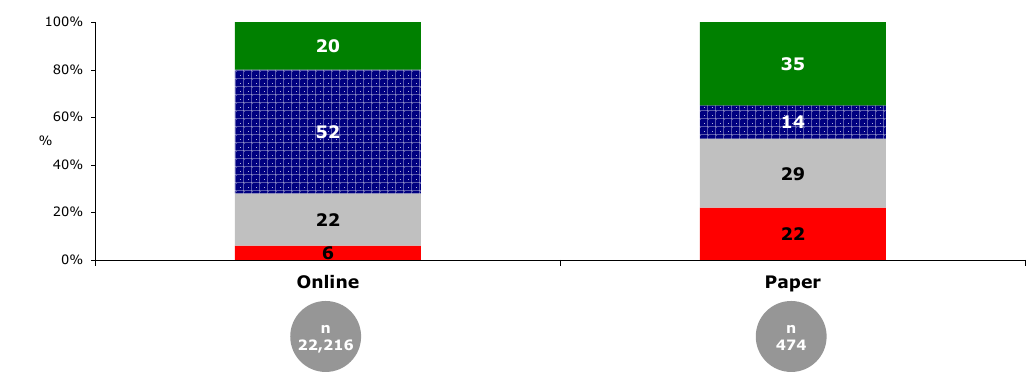
Figure 4. Downloading ability (student self-report).